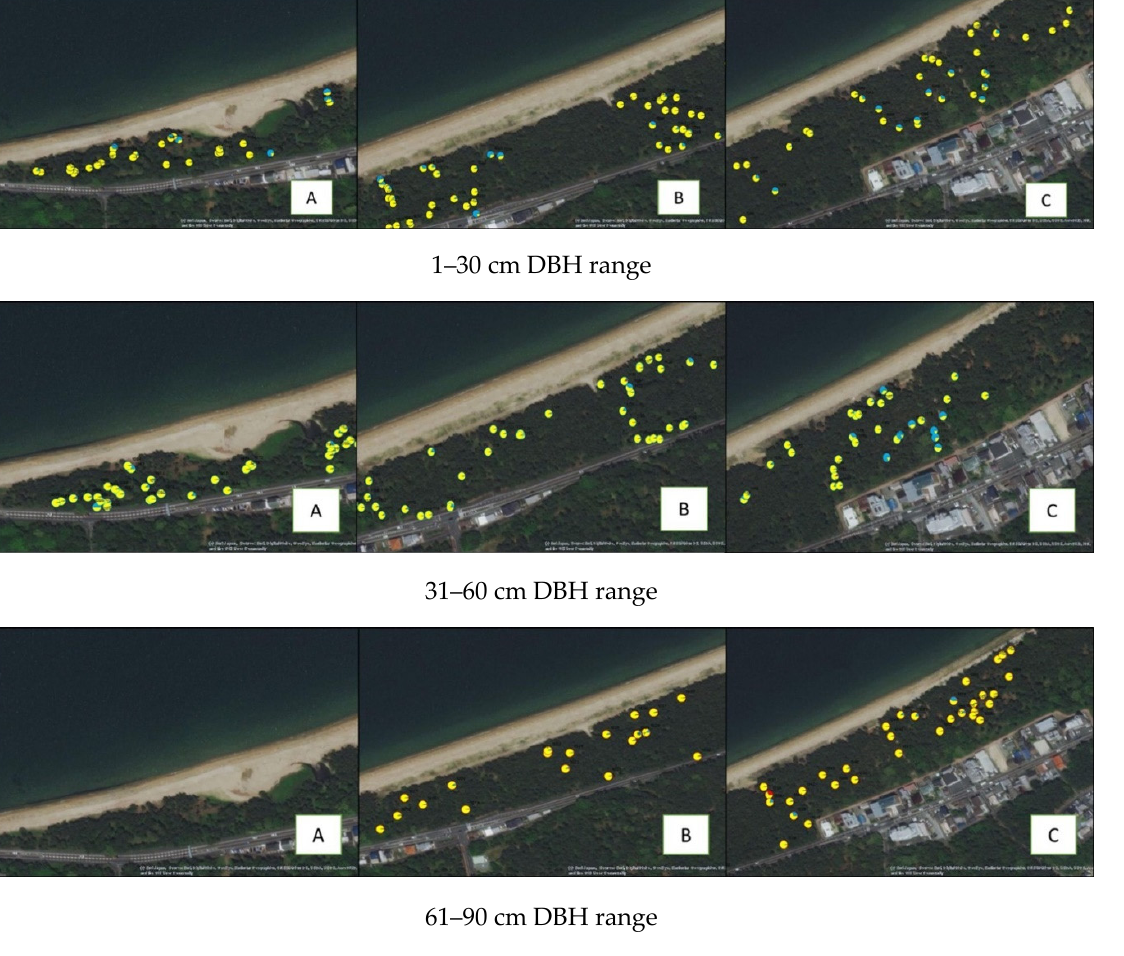
Figure A2. Spatial distribution of Iki-no-Matsubara genetic structure per DBH range ( A ) West side, ( B ) Central side, and ( C ) East side.